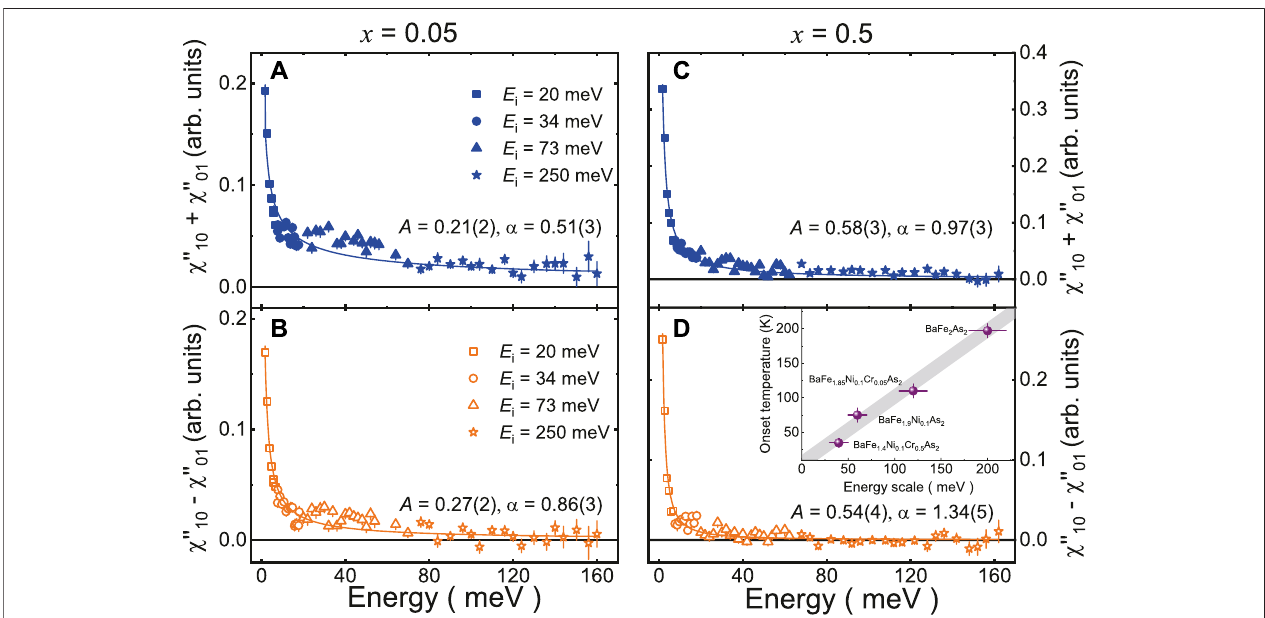
FIGURE 8 | (Color online) Energy dependence of the total spin fl uctuations χ 10 ″ + χ 01 ″ and the spin nematicity χ 10 ″ − χ 01 ″ of uniaxially detwinned samples for x =0.05 (left) and x =0.5 (right) compounds. Different symbols correspond to different incident energies in the measurements. Both of χ 10 ″ + χ 01 ″ and χ 10 ″ − χ 01 ″ can be fi tted with a power-law dependence on the energy, ~ A / E α , where the amplitude A and exponent α are listed in each panel. The inset of panel (D) shows the correlation between the highest energy and the onset temperature at low energy of χ 10 ″ − χ 01 ″